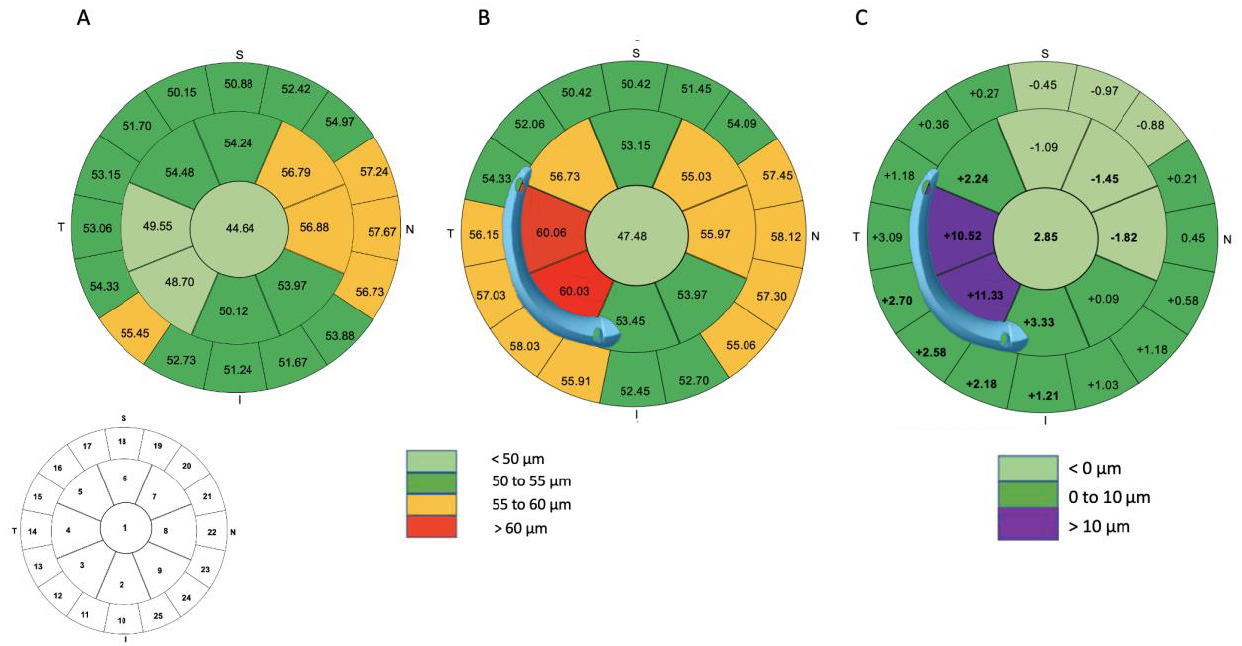
Figure 5. The mean epithelial thickness in 25 zones in the central 8 mm of the cornea is shown for the examinations performed before surgery ( A ) and 6 months after the implantation of one AJL PRO + ICRS ( B ). The mean difference in epithelial thickness ( C ) reveals a concentration of the epithelial remodeling effect on the inner part of the AS-ICRS, with stronger remodeling at the wider end than at the narrower end. Significant results are shown in bold.